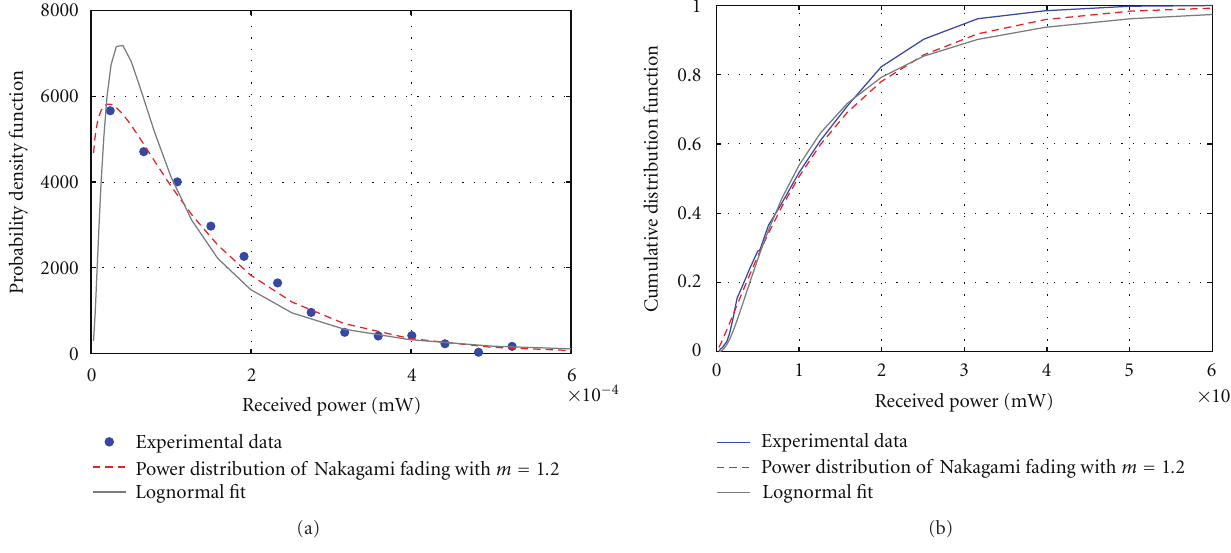
Experimental data Power distribution of Nakagami fading with m = 1 .